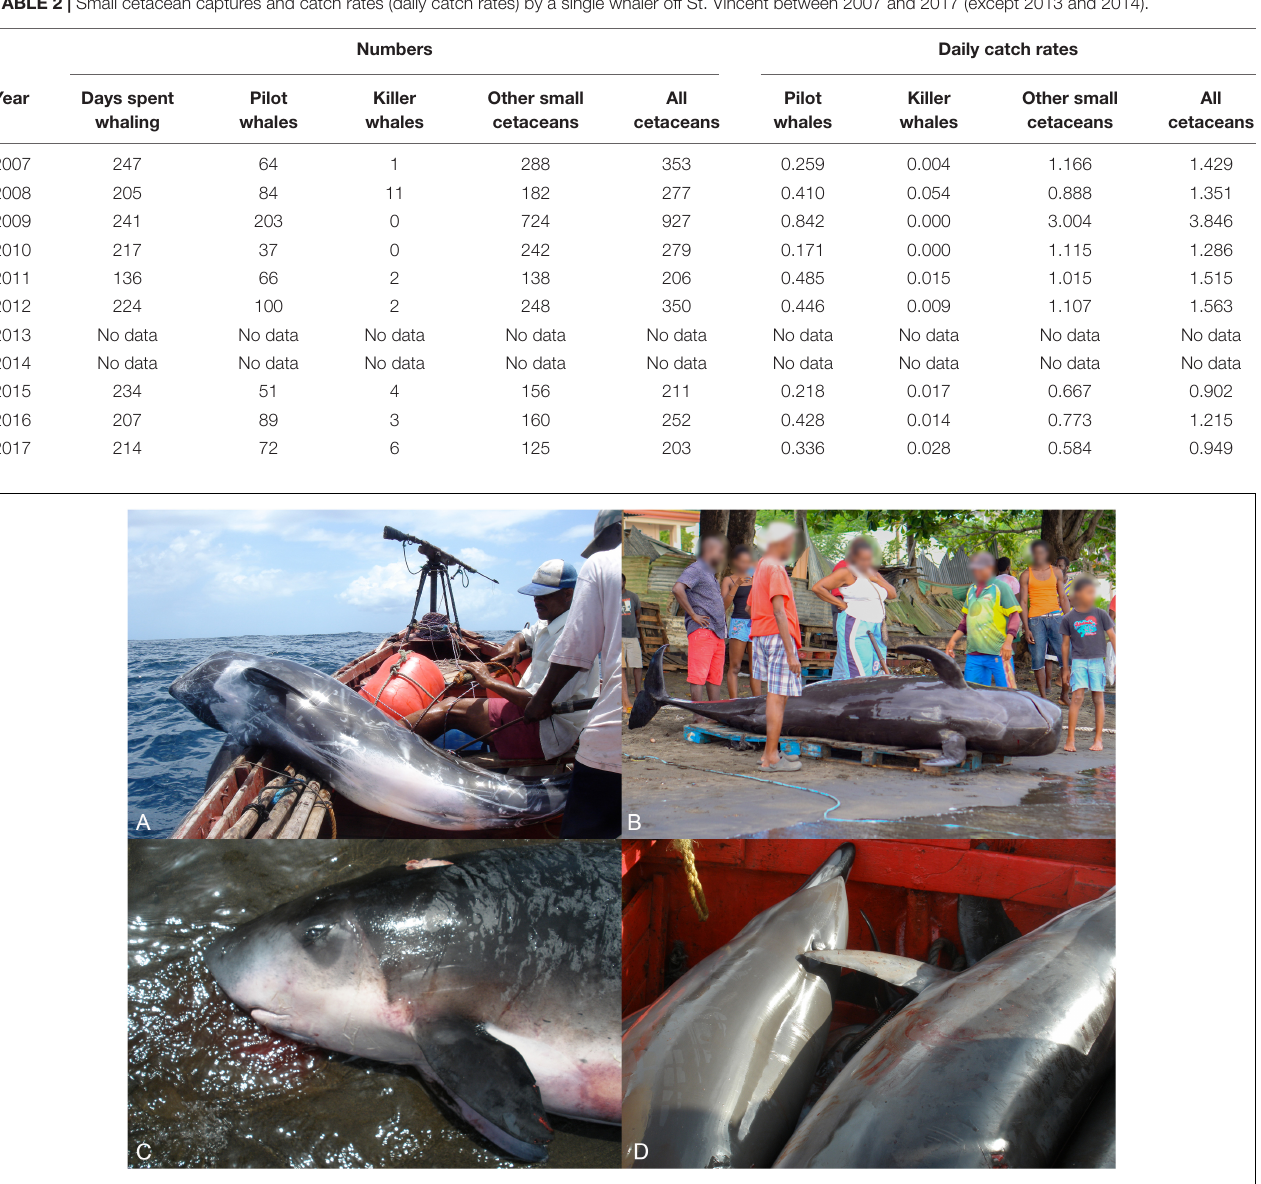
FIGURE 3 | Small cetacean captures in St. Vincent, illustrating the diversity of species caught. (A) Risso’s dolphin ( Grampus griseus ), (B) short-finned pilot whale ( Globicephala macrorhynchus ), (C) dwarf sperm whale ( Kogia sima ), and (D) Clymene’s dolphins ( Stenella clymene ). Photographs (A,C,D) by Russell Fielding; Photograph (B) by Adam